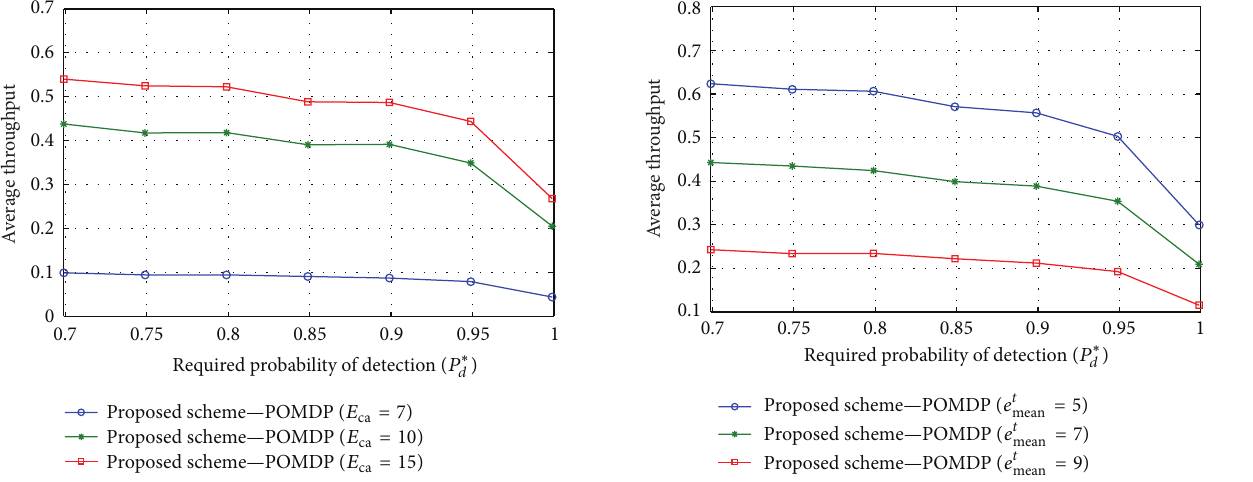
= {7, 10, 15} , 𝑒 𝑡 = 7 , and 𝑒 ℎ = 2 . ca mean mean